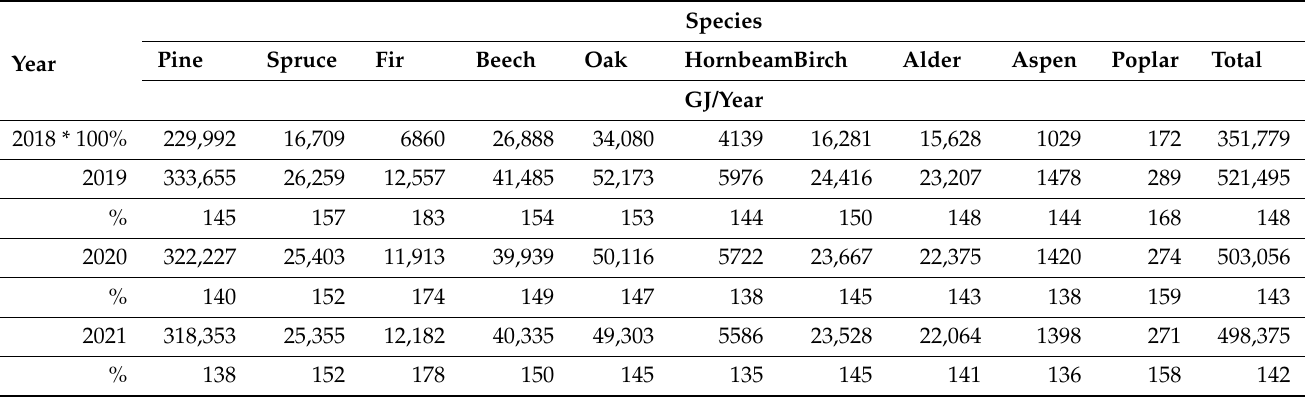
Table 11. Energy value (GJ) generated by biomass by species impact (for a biomass moisture content of 30%).